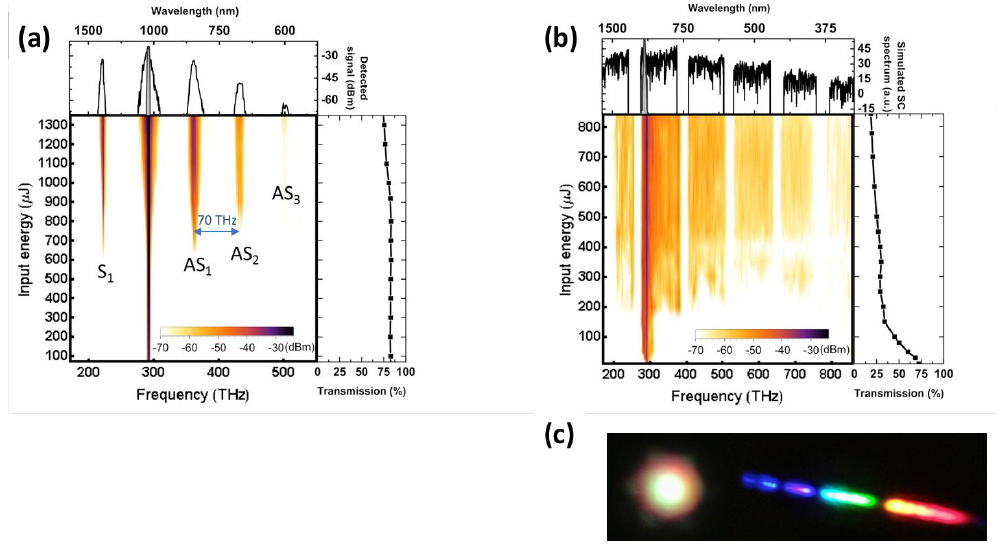
Figure 27. ( a ) Raman comb and ( b ) supercontinuum spectrum measured at the output of IC ambient air-filled IC HCPCF excited with millijoule 300 ps and 600 fs, respectively. ( c ) Dispersed-fiber output spectrum (reprinted with permission from Reference [13], OSA,